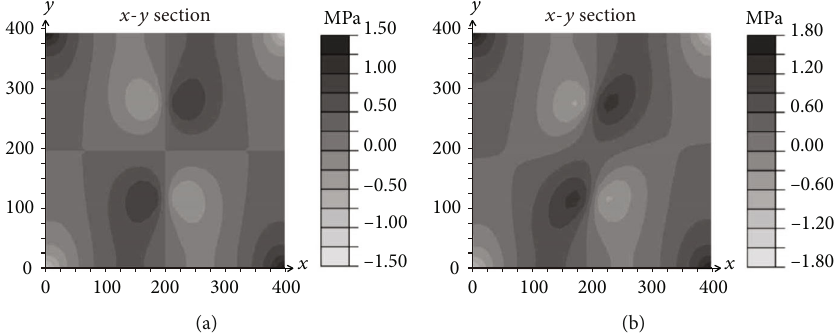
Figure 8: (a) and (b) present the induced shear stress in the x - y section with and without considering natural fractures, respectively.